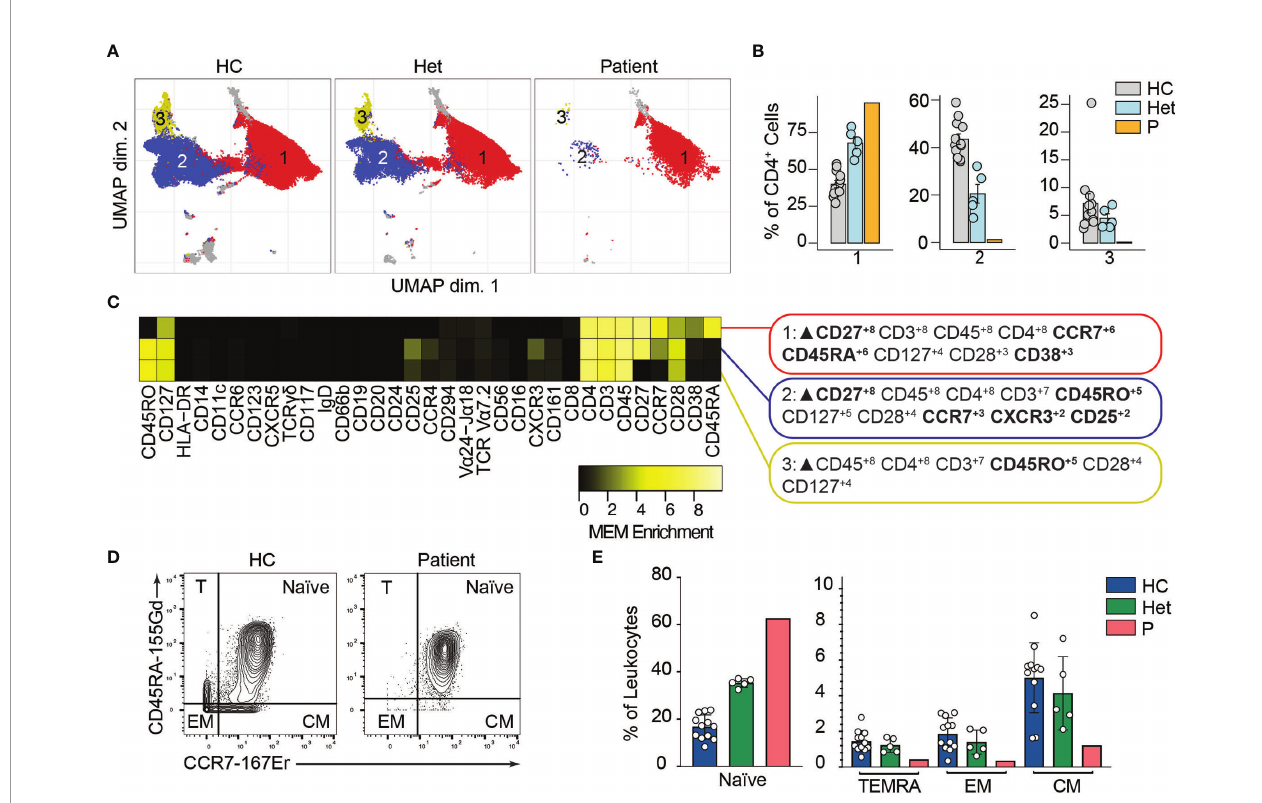
FIGURE 4 | CD4+ T cells immunophenotyping. (A) UMAP representation showing the CD4 + T population from . Each color represents a cluster obtained by unsupervised clustering using fl owSOM. 10,000 cells from healthy controls (HC), heterozygous carriers (Het), and the patient are represented. (B) Frequencies of the fl owSOM clusters highlighted in (A) as a percentage of total cells in the CD4 + T cell cluster from . (C) MEM heatmap and marker tags for the clusters shown in (A) . In bold are highlighted the markers differentially expressed between clusters. (D) CD45RA vs. CCR7 CD4 + T cell gating example for a representative healthy control (HC) and the patient. Detailed gating strategy is shown in Figure S2 . (E) Frequencies of Naïve, TEMRA, effector memory (EM) and central memory (CM) CD4 + T cells in healthy controls (HC), heterozygous carrier (Het), and patient as a percentage of leukocytes obtained by manual gating in